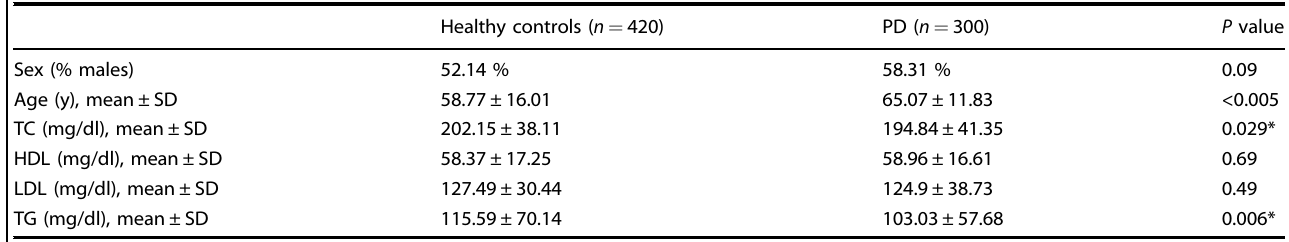
Table 2. The familial PD groups ( GBA -PD and LRRK2 -PD) were younger than sPD and showed a lower age of PD onset. GBA -PD had a predominance of males (73.91%), whereas LRRK2- PD showed a higher proportion of females (62.98%). Although these PD groups had a longer disease duration than sPD, there were no differences between groups either in the severity of the disease or in the treatment. There were no signi fi cant differences in arterial hypertension, diabetes, or hyperlipidemia among the groups (Table 2). When we compared the serum lipid pro fi le among PD cohorts and HCs, we found statistically signi fi cant differences in TC levels [ F (3,663) = 4.99, P < 0.005] and LDL [ F (3,502) = 3.85, P <0.05] after adjusting for age and sex (Table 3). GBA -PD showed the lowest levels of TC and LDL (178.22 ± 34.47 and 105.78 ± 29.85 mg/dl, respectively), while LRRK2- PD patients had the highest levels of both TC and LDL (213.73 ± 30.01 and 141.09 ± 30.48 mg/dl, respectively). TC and LDL levels of sPD were lower than HCs and LRRK2- PD but higher than the levels of GBA -PD patients. No differences were found between the groups in HDL levels. Regarding the triglycerides, HCs showed higher serum triglycerides levels than sPD, GBA -PD, and LRRK2- PD. However, these differences in triglycerides were not statistically signi fi cant